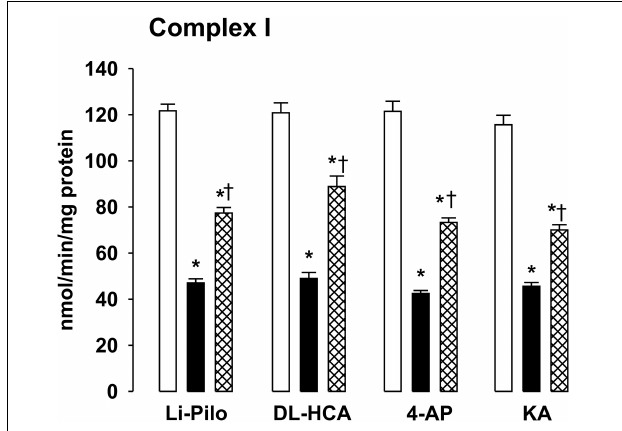
FIGURE 5 | Effect of resveratrol on mitochondrial complex I activity at ∼ 20 h of survival after SE induced in immature rats by Li-Pilo, DL-HCA, 4-AP, or KA. White columns, controls; black columns, convulsant agent alone; cross-hatched columns, convulsant agent plus resveratrol. Results are expressed as nmol/min/mg protein. Mean values for 4–6 animals ± SEM. * P < 0.05 as compared with controls; † P < 0.05 as compared with convulsant agent